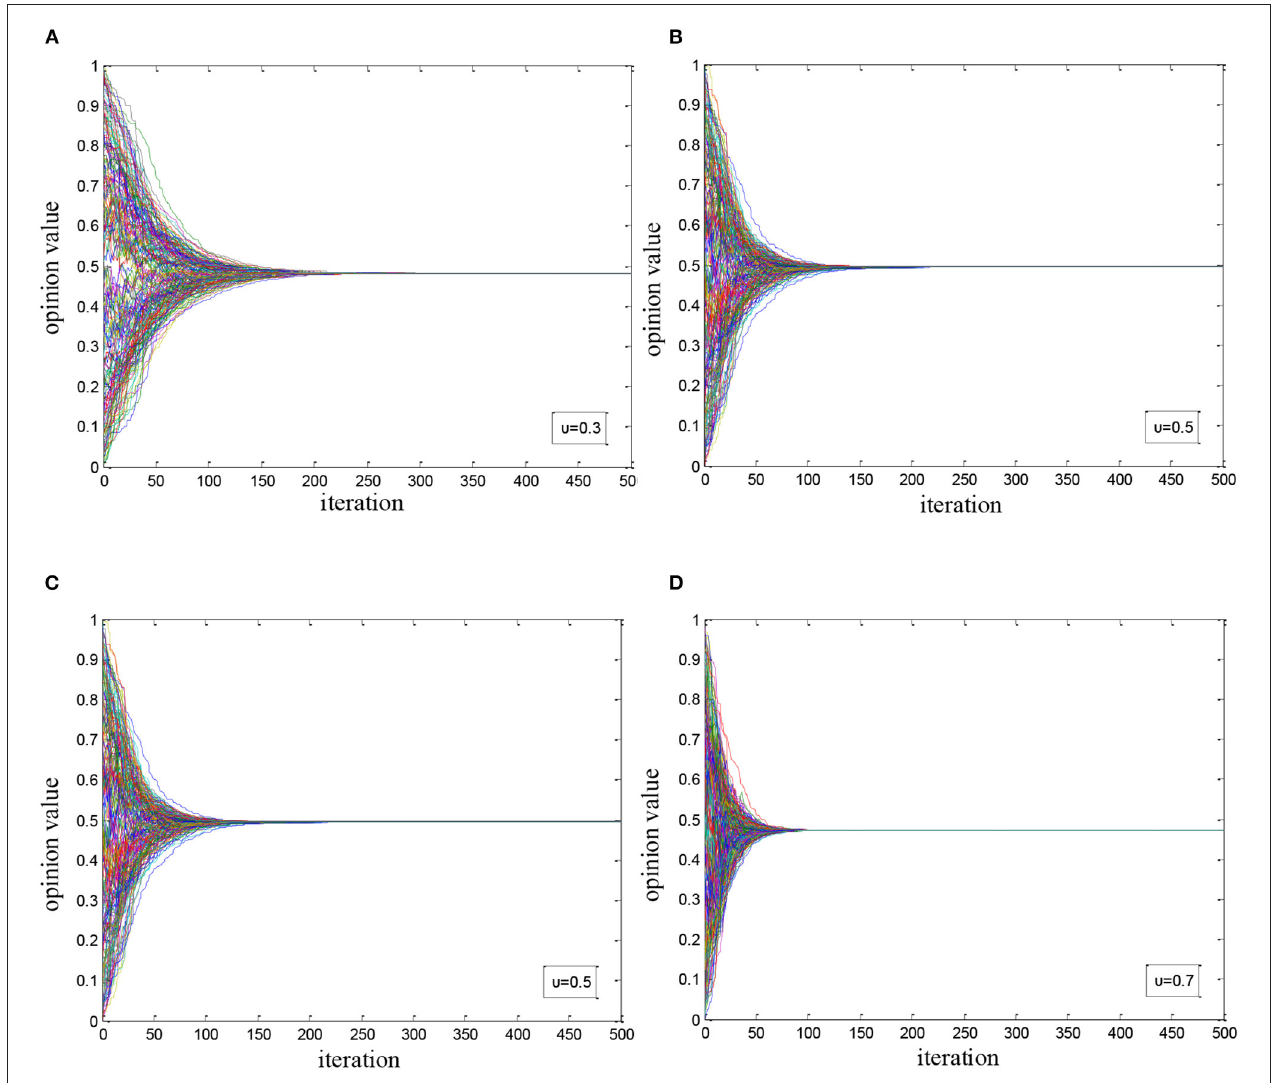
FIGURE 1 | Simulation of health opinion evolution under pure environment: (A) u = 0.1; (B) u = 0.3; (C) u = 0.5; and (D) u =